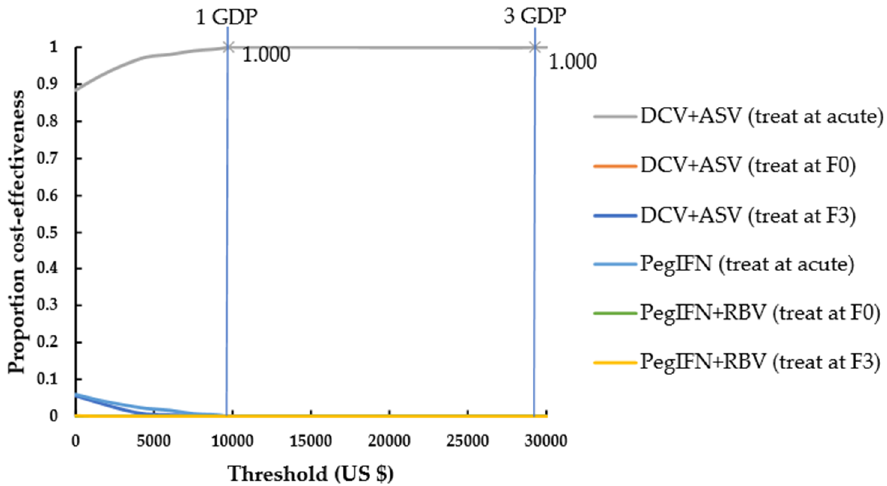
Figure 2. Cost-effectiveness acceptability curves for all strategies. F0, no fibrosis; F3, numerous septa without cirrhosis; GDP, gross domestic product. IFN, interferon; DCV, Daclatasvir; ASV, Asunaprevir; RBV, ribavirin.